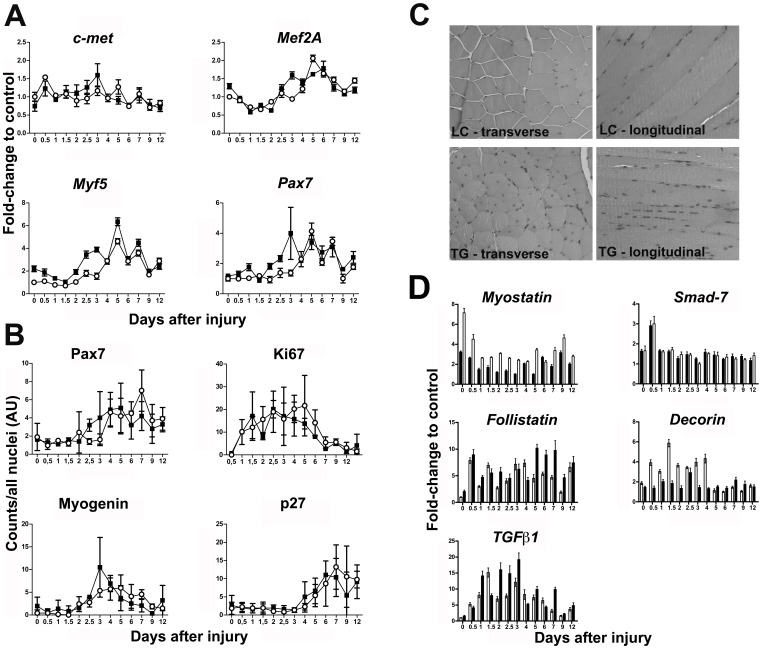
Analysis of skeletal muscle regeneration and the myostatin regulatory pathway in Dlk1 transgenic (TG) and littermate control (LC) mice by qPCR and morphometrics.A: qPCR analysis of c-met, Mef2a, Myf5, and Pax7, Myod mRNA levels, during regeneration of Dlk1+ TG and LC control mice. The relative expression levels were normalized to expression of the reference genes 18s rRNA, Hprt1, Pgk1 and Tbp and the mRNA levels were calculated as fold-change to uninjured LC control muscle (calibrator = 1) for both genotypes. The qPCR represents a pool of m. gastrocnemius harvested from 3 mice for each time point and genotype and was run in triplicates. Black squares: Dlk1 TG mice +/− SD. Open circles: LC control mice +/− SD. B: Morphometric analysis of Pax7, ki67, myogenin and p27 protein expression during regeneration of Dlk1 TG and LC control mice (n = 3 in each group for each genotype). Black squares: Dlk1 TG mice +/− SD. Open circles: LC control mice +/− SD. C: Presence of centrally localized nuclei in Dlk1 TG muscle compared to LC controls is shown both as transverse and longitudinal sections representing 2 different individuals for each genotype. D: qPCR analysis of Myostatin, Follistatin, TGFβ1, Smad7 and Decorin mRNA expression during regeneration of Dlk1 transgenic mice and littermate controls. The qPCR is presented as fold-change to uninjured LC control muscle (calibrator = 1). The relative levels have been determined by normalizing the data to 18s rRNA, Gapdh, Hprt1, Pgk1 and Tbp as described in materials and methods. Black bars: Dlk1 TG mice +/− SD. White bars: LC control mice +/− SD.